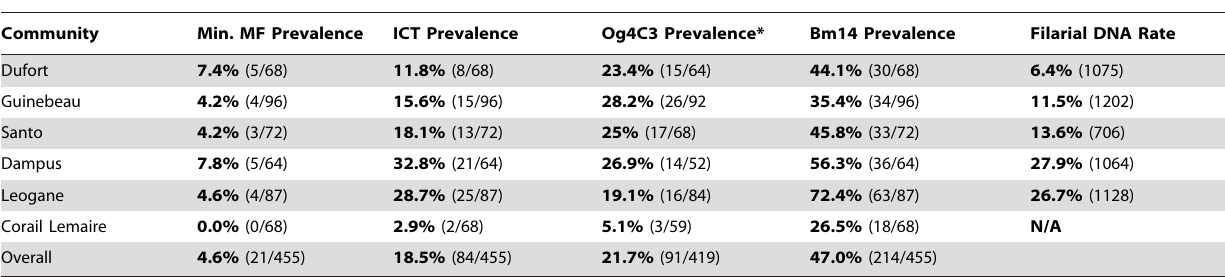
Table 2. Infection measures by community.